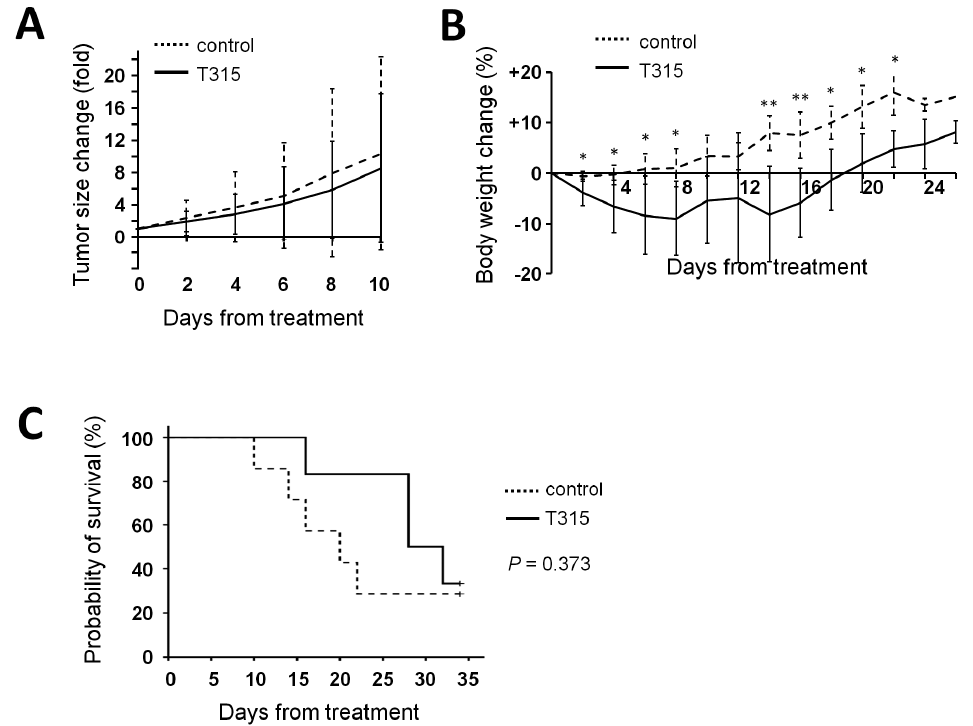
Figure 6. T315 mitigates the growth of THP-1 xenografts and prolongs the survival of tumor-bearing athymic nude mice. ( A ) Mice bearing THP-1 xenografts were treated with DMSO vehicle ( ⋅⋅⋅⋅⋅⋅ , n = 7) or T315 ( ⎯⎯ , n = 6) at 37.5 mg/kg/day intraperitoneally. The data represent group means and were plotted until day 10 when one mouse in the control group reached the endpoint tumor size ( ≥ 2000 mm 3 ) and was sacrificed; ( B ) Body weight change of mice. The data were plotted until day 26 when the control group and treated group had 2 and 3 mice remaining, respectively; ( C ) Overall survival curve plotted by Kaplan-Meier method. * denotes p < 0.05; ** denotes p < 0.01 compared to the control group.